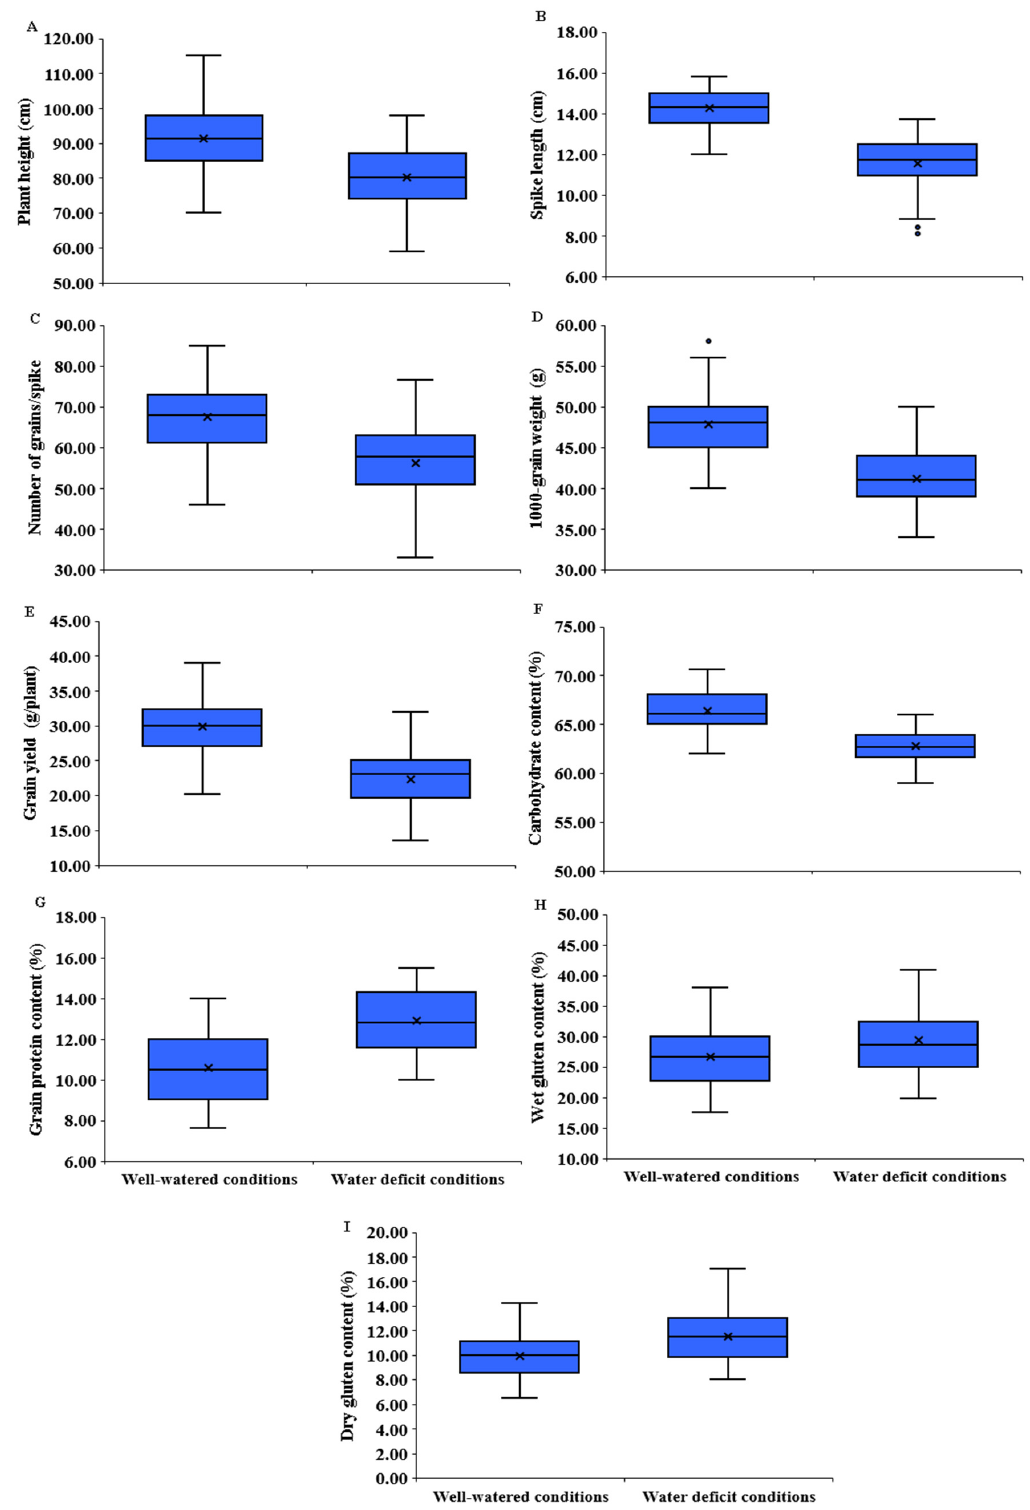
Figure 4. Boxplots with minimum, median, mean, and maximum values for plant height ( A ), spike length ( B ), number of grains per spike ( C ), 1000-grain weight ( D ), grain yield per plant ( E ), carbohydrate content ( F ), ( G ) protein content, ( H ) wet gluten content, and ( I ) dry gluten content.